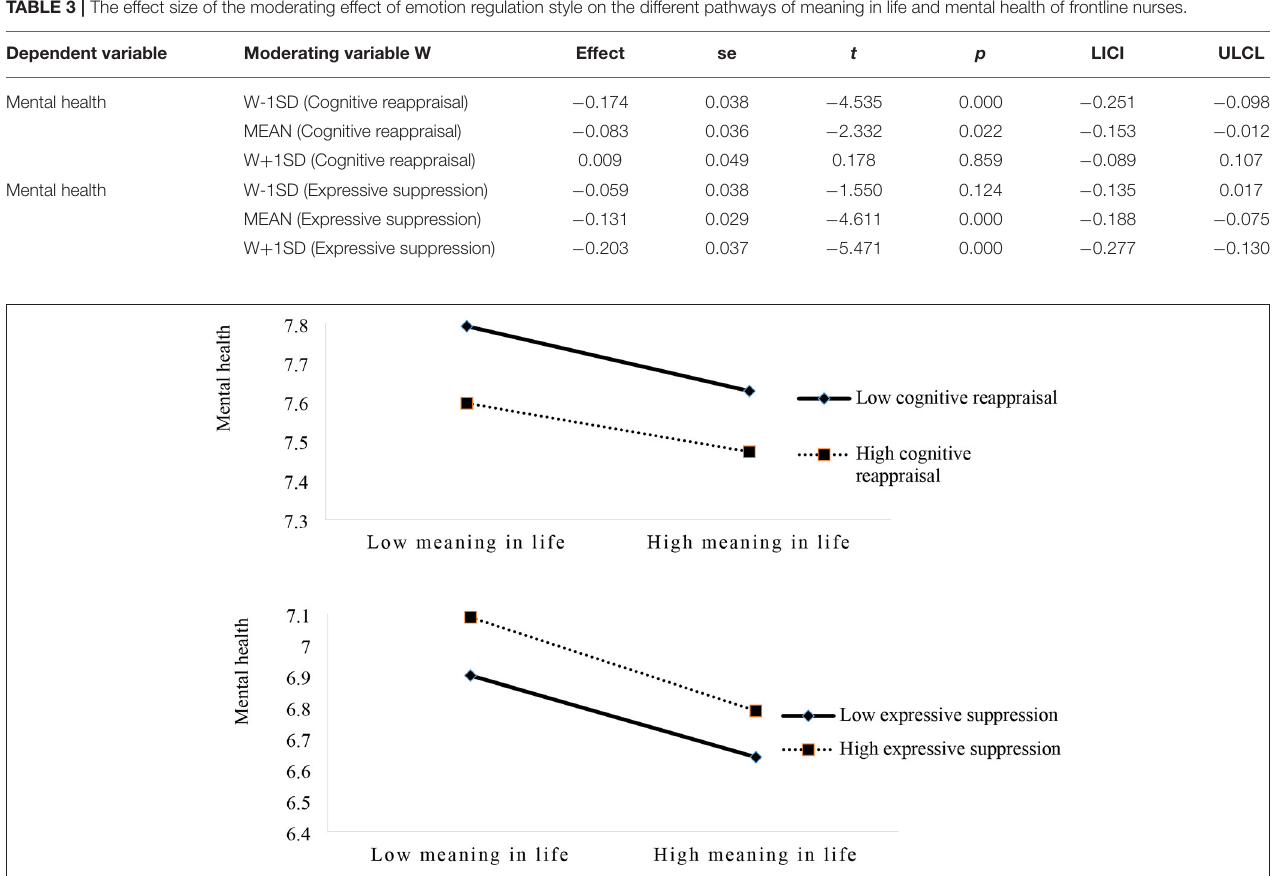
FIGURE 1 | The moderating effect of emotion regulation on meaning in life and mental